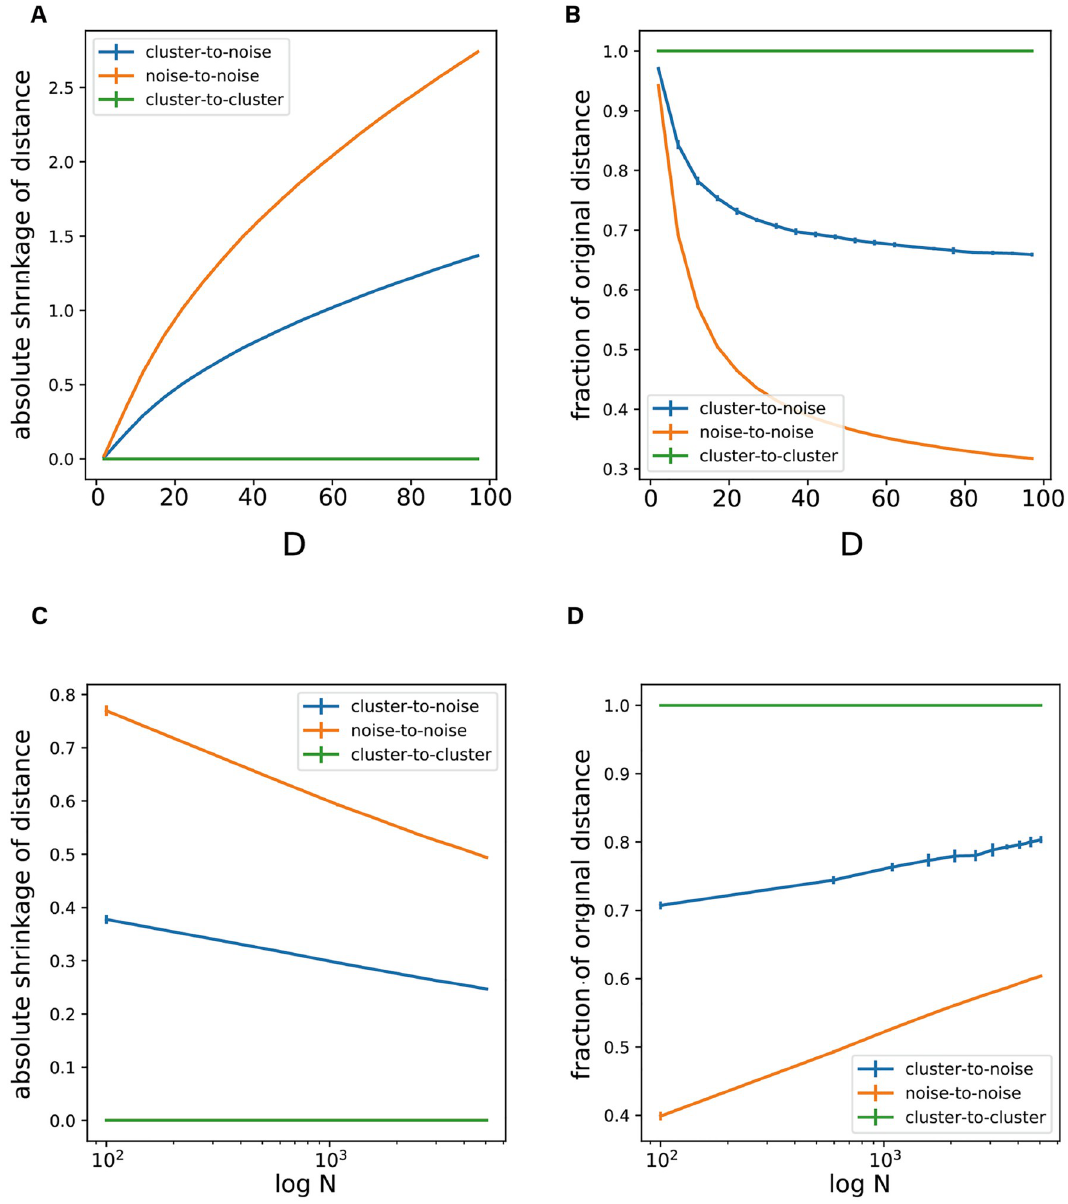
Fig 3. Influence of dimensionality and number of points on distance-of-distances. A-B : Influence of dimensionality D on distance- of-distances. A : Absolute shrinkage of Euclidean distance (i.e. original distance minus the distance-of-distances) as a function of dimensionality D . B : Fraction of original distance (distance-of-distances divided by original distance) as a function of dimensionality D . The distance between cluster points is unaffected by the Distance-to-Distance transformation (because the clusters had infinite density). Because of the DoD transformation, the distance between noise points shrinks more than the distance between cluster and noise points. As a result, noise points become relatively more similar to each other than to other cluster points. C-D . Influence of the number of points N on distance-of-distances. C : Absolute shrinkage of distance as a function of number of points N . D : Fraction of original distance as a function of number of points N . As the number of data points increases, the noise-to-noise and cluster-to-noise distance-of-distances become more similar to each other. The dimensionality in this example was D = 20. The number of neighbors w. r.t which distance-of-distances were computed was 10. The error bar indicates the standard deviation across simulations with different initialization settings.